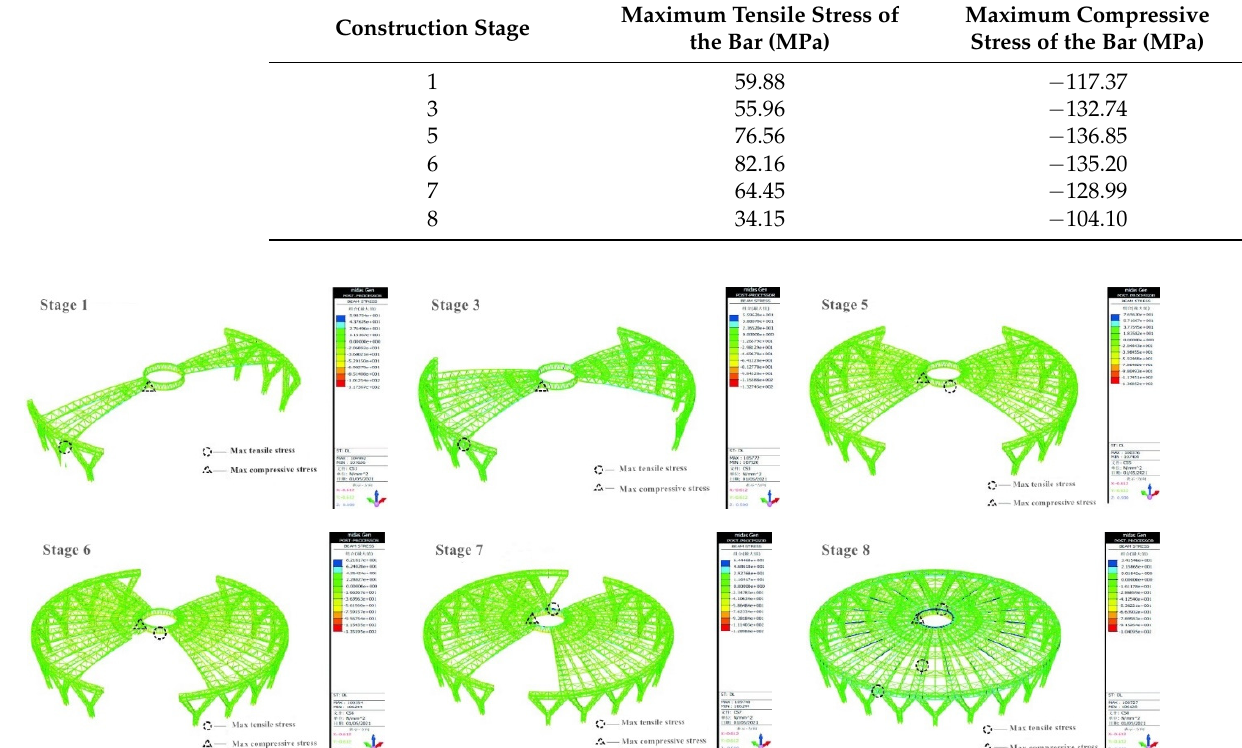
Figure 11. Cloud diagram for stress during construction.